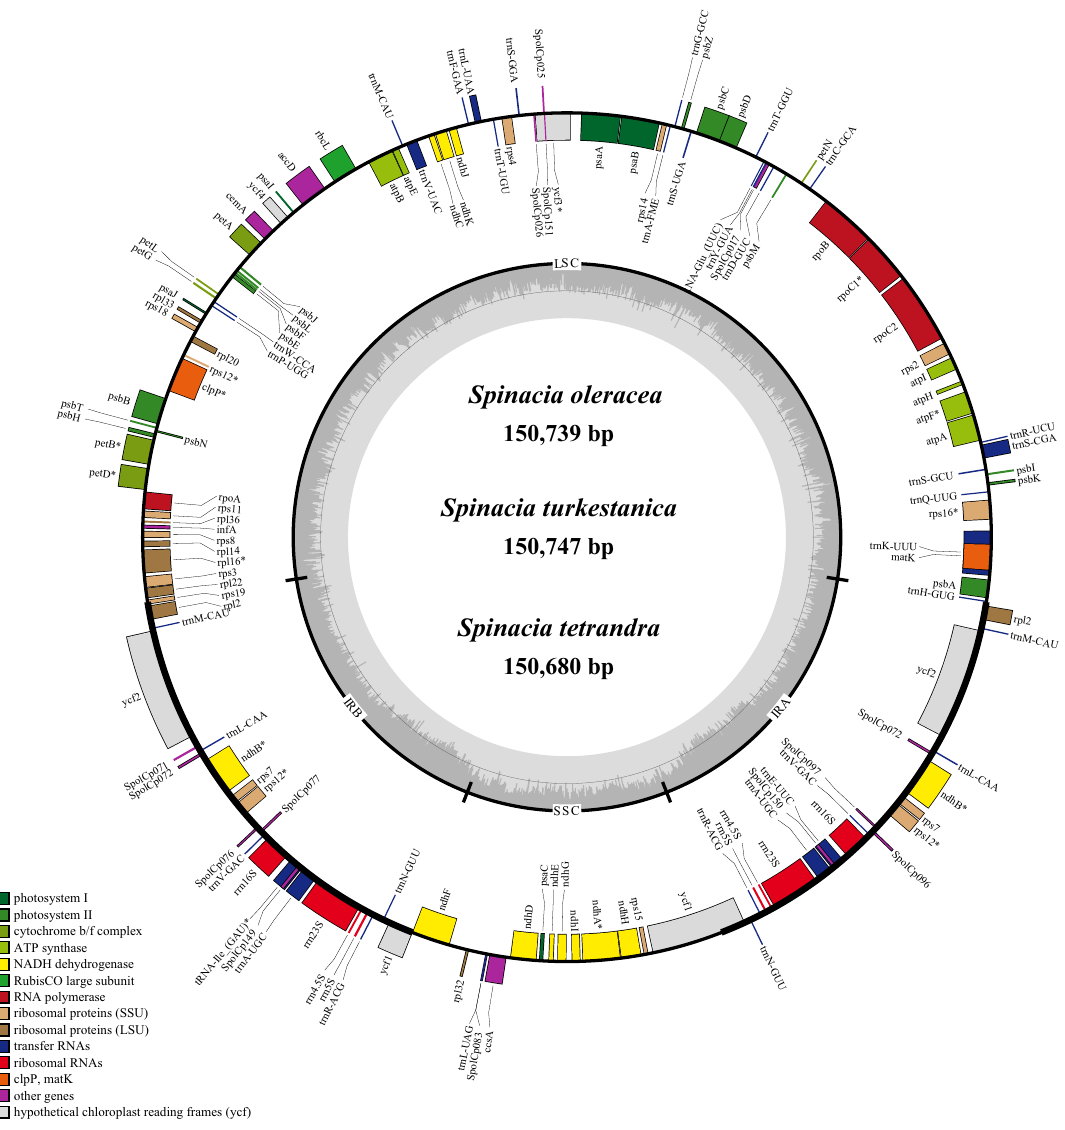
Figure 1. The chloroplast genome maps of the three Spinacia species. Genes shown inside the circle are transcribed clockwise, and those outside the circle are transcribed counterclockwise. Genes belonging to different functional groups are